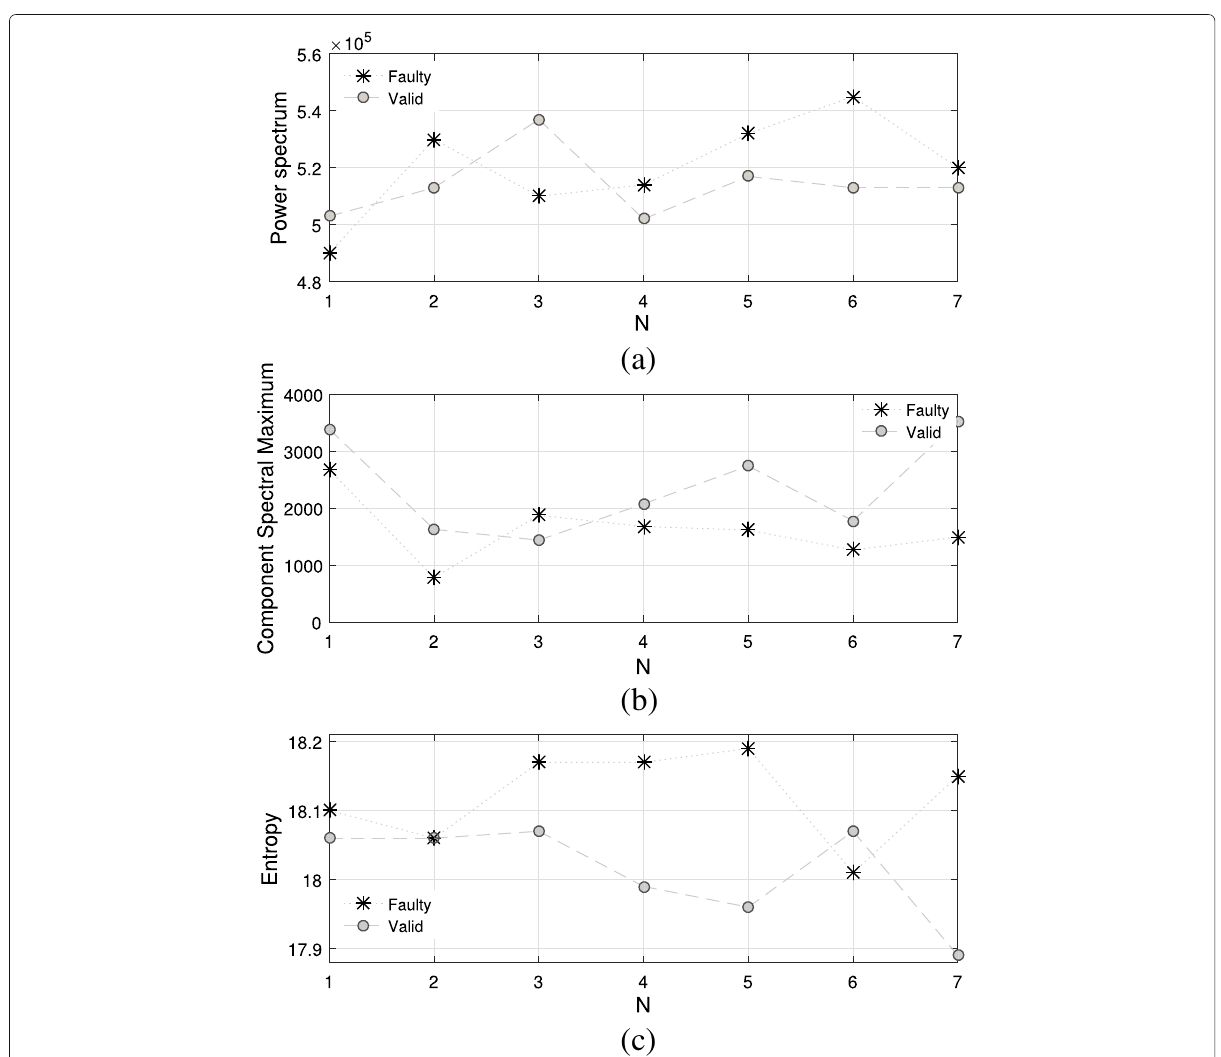
Fig. 3 a Signal energy, b spectrum maximum value inside components’ bandwidth, and c global entropy spectrogram’s entropy value for measured